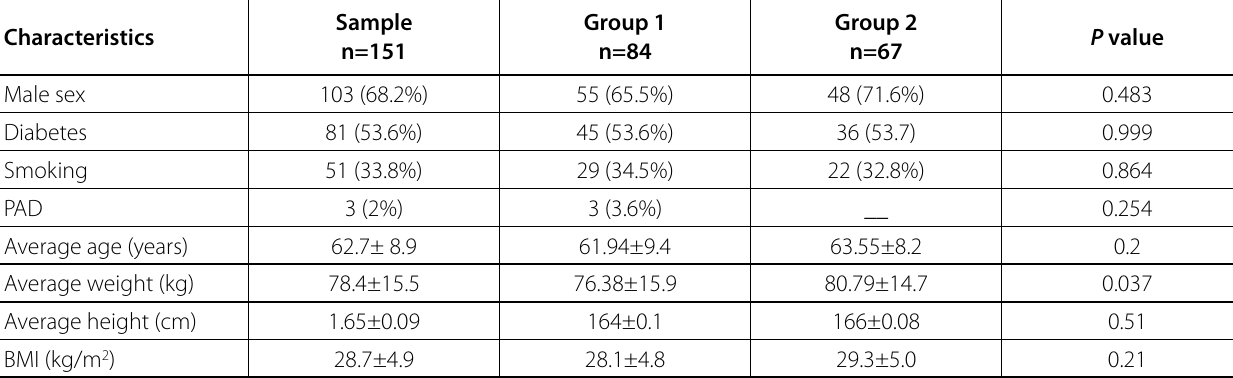
Table 1 . Preoperative clinical characteristics of the groups.